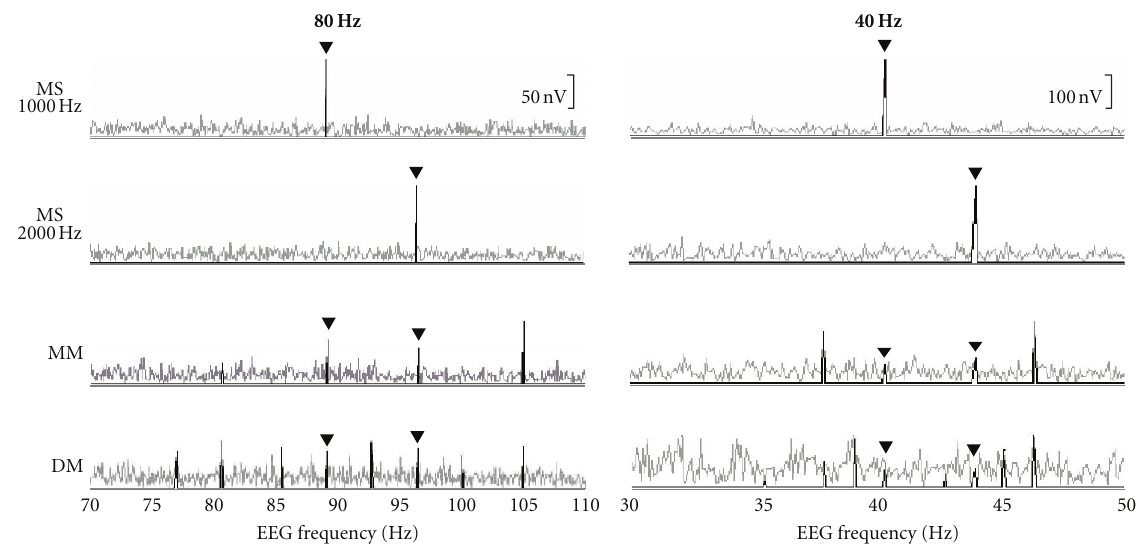
Figure 2: Representative SNHL subject’s ASSR amplitude spectra in the MS, MM, and DM stimulus conditions. Filled triangles indicate response to 1000- and 2000-Hz